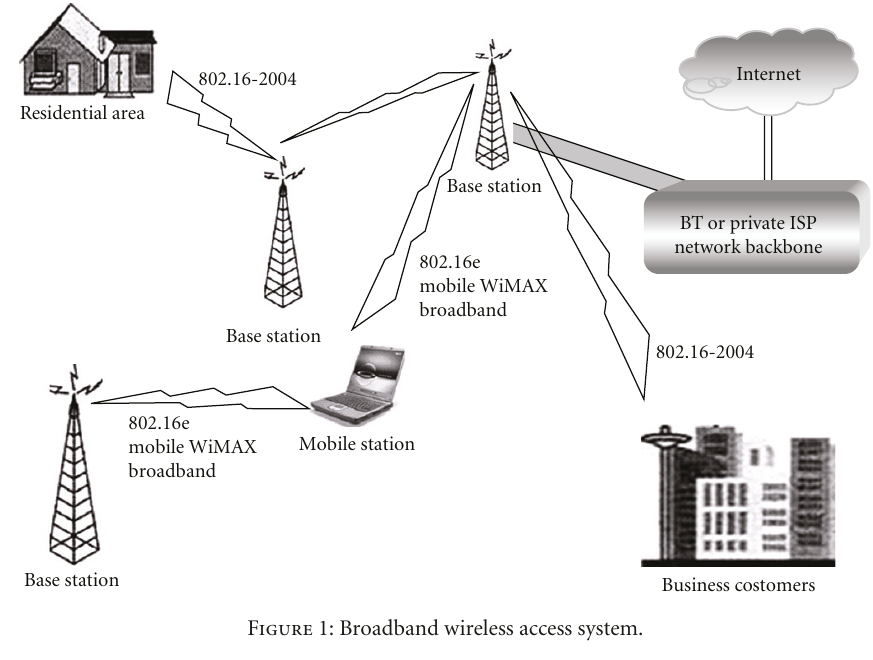
Figure 1: Broadband wireless access system.